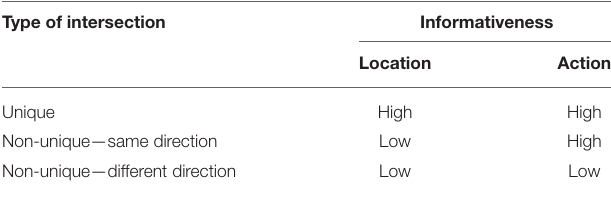
TABLE 1 | Manipulation of the two dimensions location and action of landmark informativeness (Stankiewicz and Kalia, 2007) at the three types of intersections used in Experiment